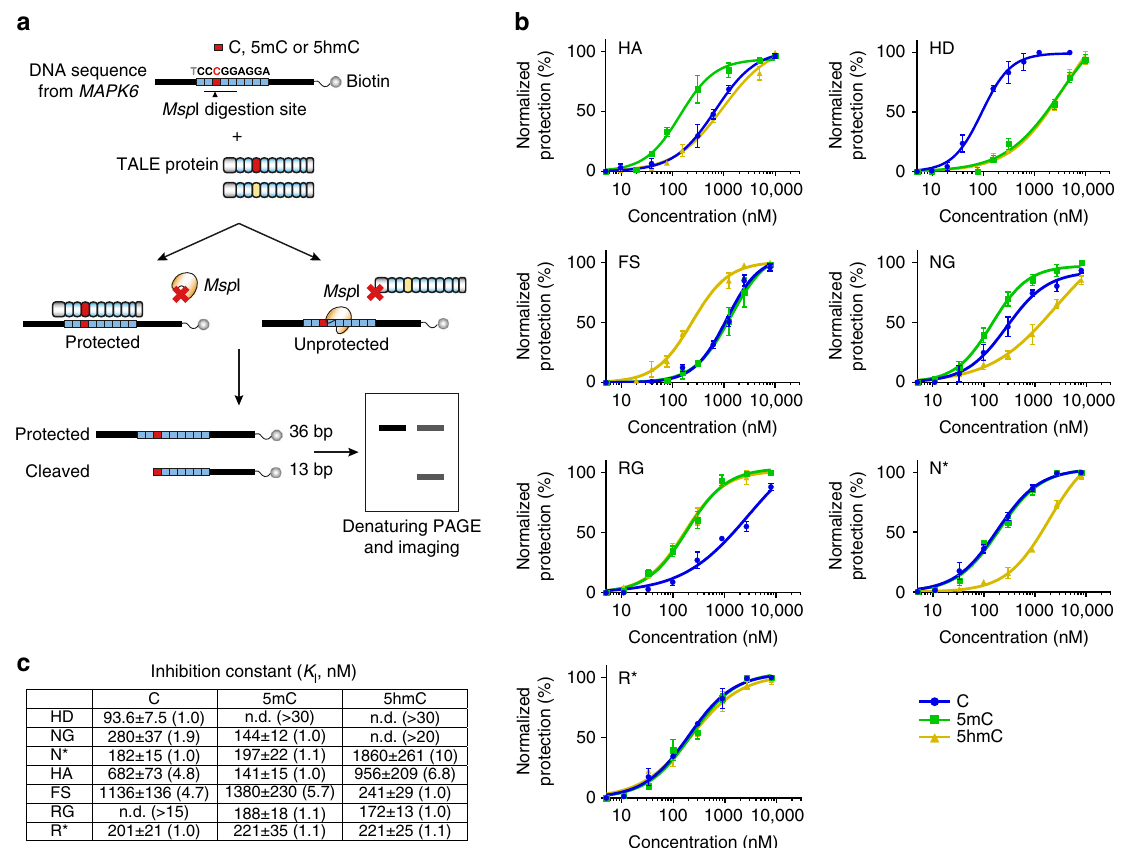
Fig. 3 Quantitative measurement of DNA recognition by TALE RVDs using an in vitro protection assay. a Principle of in vitro protection assay. Brie fl y, binding of TALE proteins to their cognate cytosine bases will inhibit the endonuclease cleavage, thereby resulting in a protected full-length band and a cleaved-DNA band during denaturing PAGE analysis. b The normalized protection ef fi ciency, as measured by the fraction of the uncleaved or protected DNA, are fi tted into protection curves of different TALE RVDs. The curves are fi tted into speci fi c binding curve with Hill slope (GraphPad). c Inhibition constant calculated from b . The ratio of each constant to the lowest constant of the same RVD is indicated within the parentheses. The data are means ± s.d., n = 3; * P < 0.05, and ** P < 0.005 two-tailed unpaired Student ’ s t